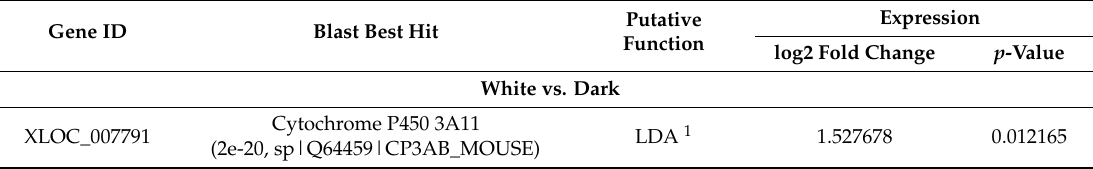
Table 4. C. unicolor differentially expressed genes encoding for wood-degrading enzymes detected during fungus growth in different lighting